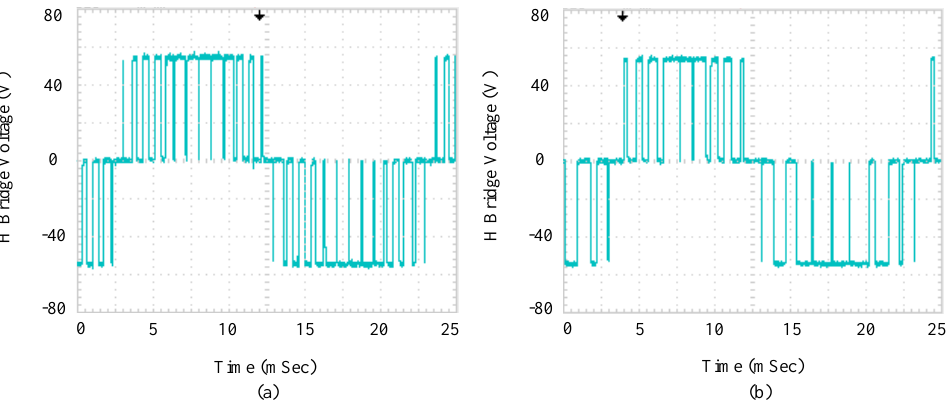
Figure 17. Output voltages of one power cell under the optimized new strategy and discontinuous modulation strategy (Modulation depth, M = 0.95): ( a ) Output voltage under the optimized new strategy; ( b ) Output voltage under discontinuous modulation strategy.